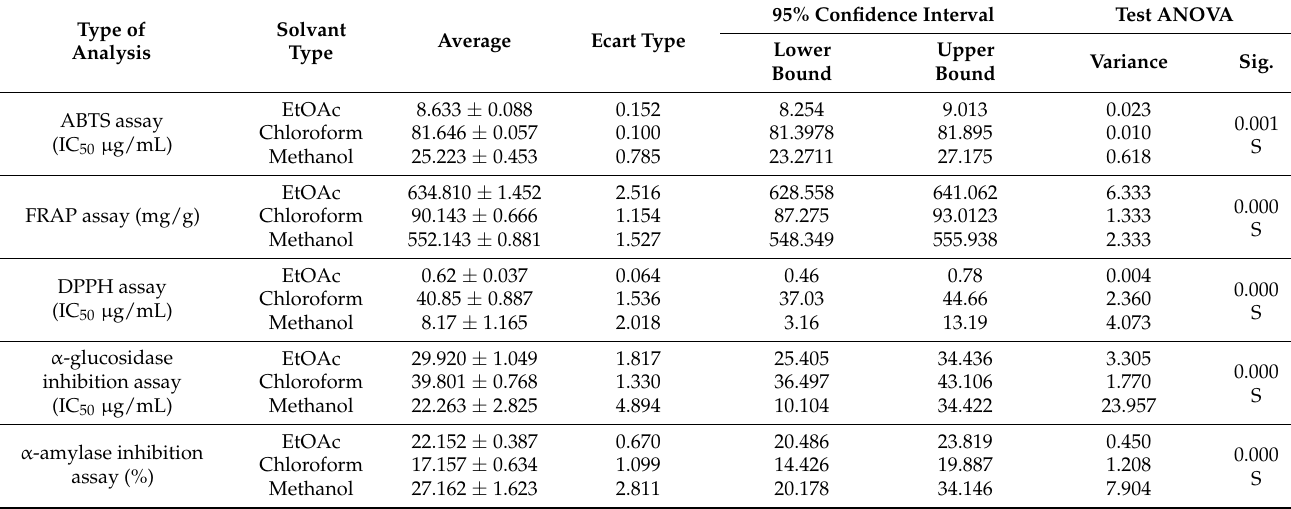
Table 7. Statistical analysis of the means performed by one-way analysis of variance (ANOVA). Type of